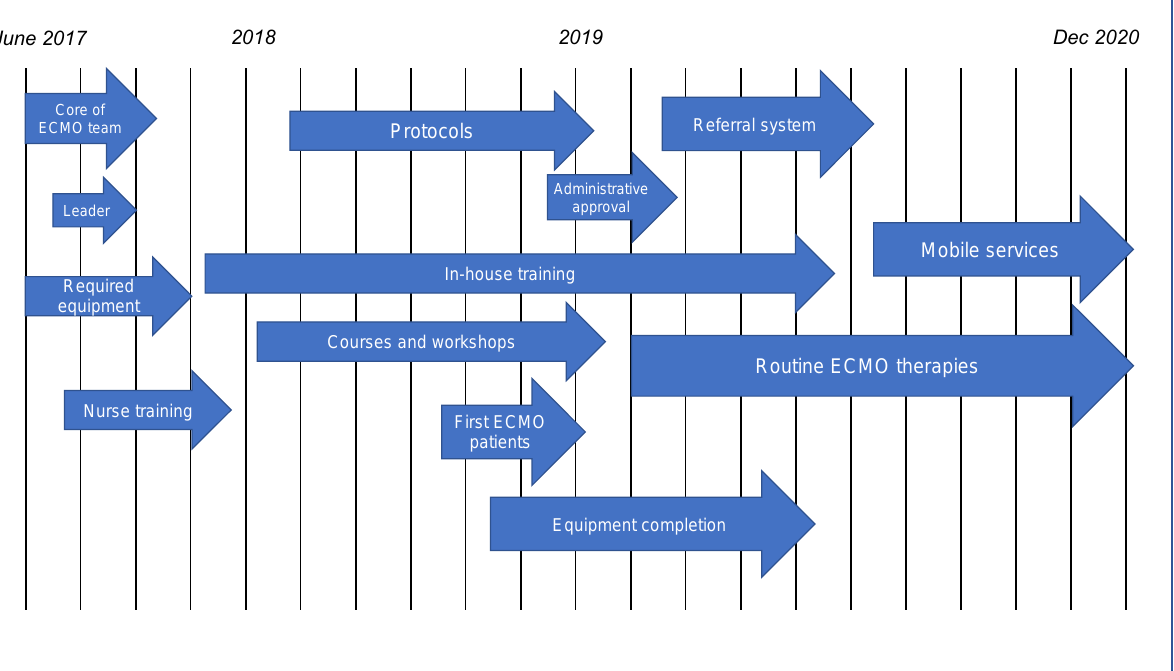
Figure 1. Timeline of the ECMO center progression.